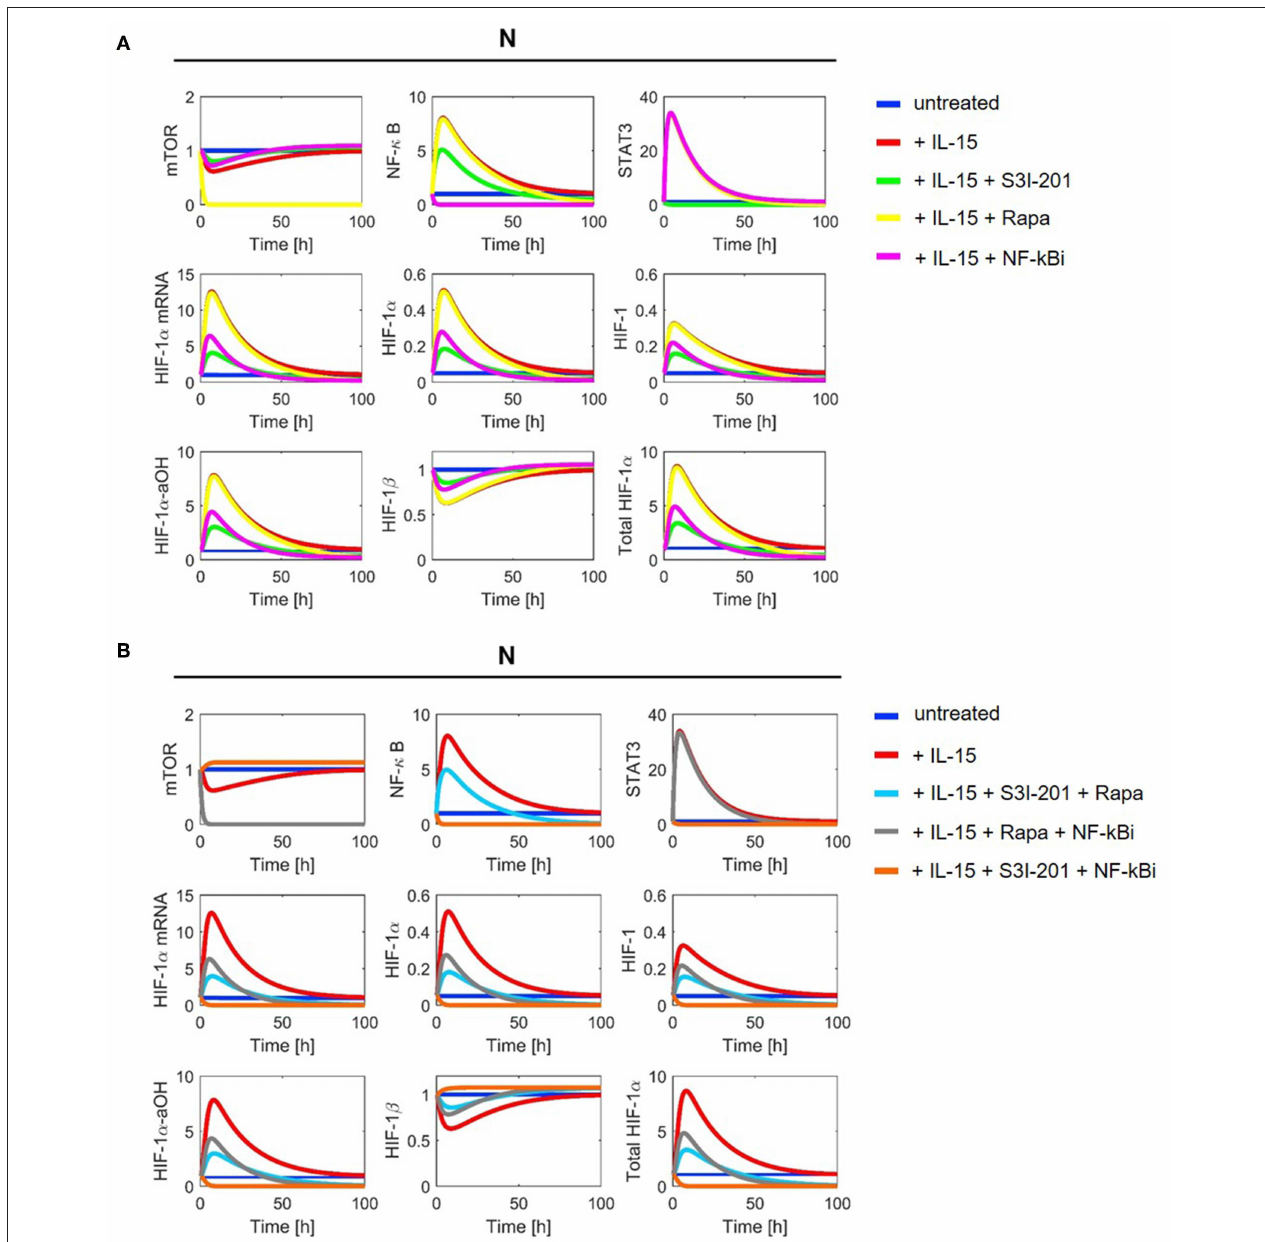
FIGURE 4 | Model simulation in NK cells without DMOG (N): (A) with one inhibitor and (B) with two inhibitors. Colors indicate the following experimental settings: (blue) untreated cells; (red) cells primed with IL-15; (green) cells primed with IL-15 and treated with STAT3 inhibitor S3I-201; (yellow) cells primed with IL-15 and treated with mTOR inhibitor rapamycin (Rapa); (magenta) cells primed with IL-15 and treated with NF- κ B inhibitor (NF- κ Bi); (cyan) cells primed with IL-15 and treated with STAT3 inhibitor and rapamycin; (gray) cells primed with IL-15 and treated with NF- κ B inhibitor and rapamycin; (orange) cells primed with IL-15 and treated with NF- κ B and STAT3